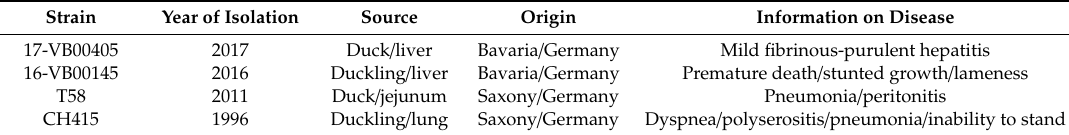
Table 1. Vibrio cholerae non-O1, non-O139 strains used in this study. Strain